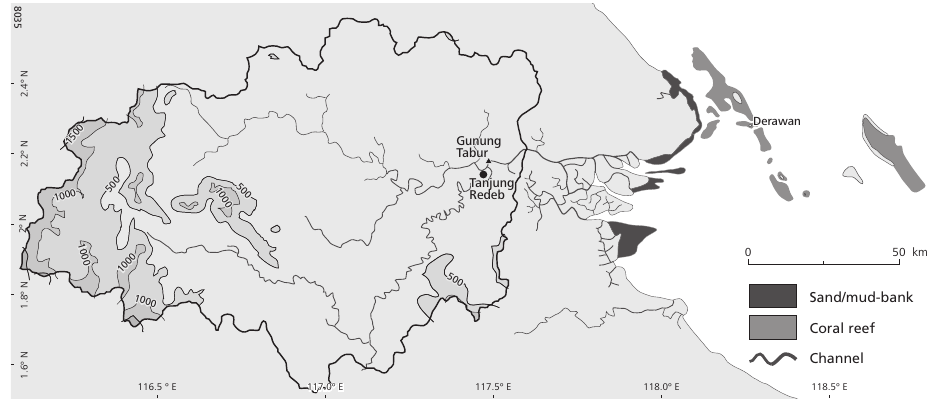
Fig. 1. Map of the Berau region showing the Berau drainage basin with contour heights (m), the river and estuarine channels and the coral reef islands in the